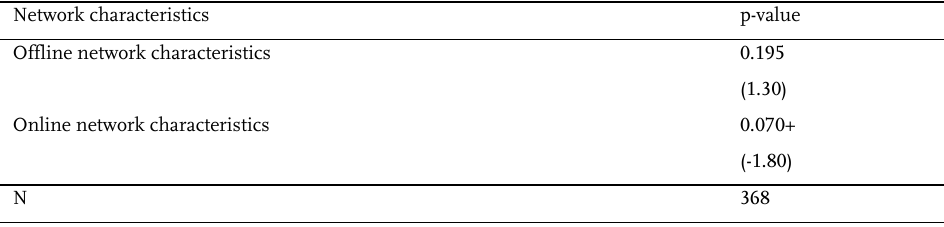
Table 4 : KHB decomposition analysis: Significance (p -value) of the indirect effect of gender via network